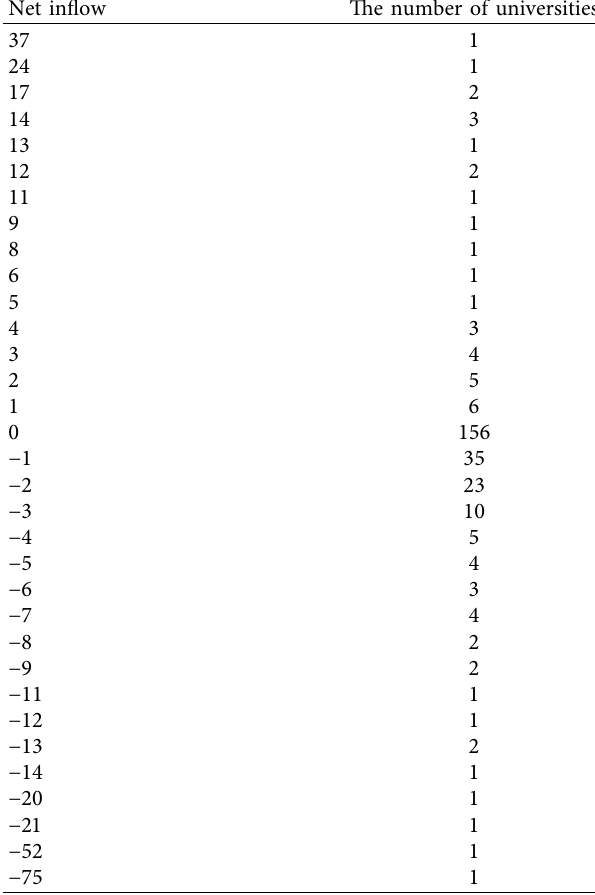
Table 7: The distribution of net talent flows of doctoral students. Net inflow